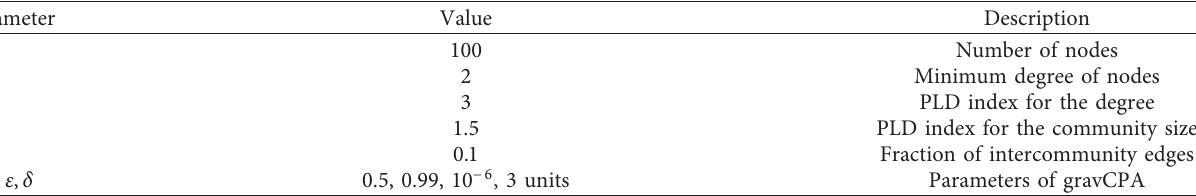
Figure 5: Response latency curve of controllers’ number k . Table 4: Simulation parameters settings.